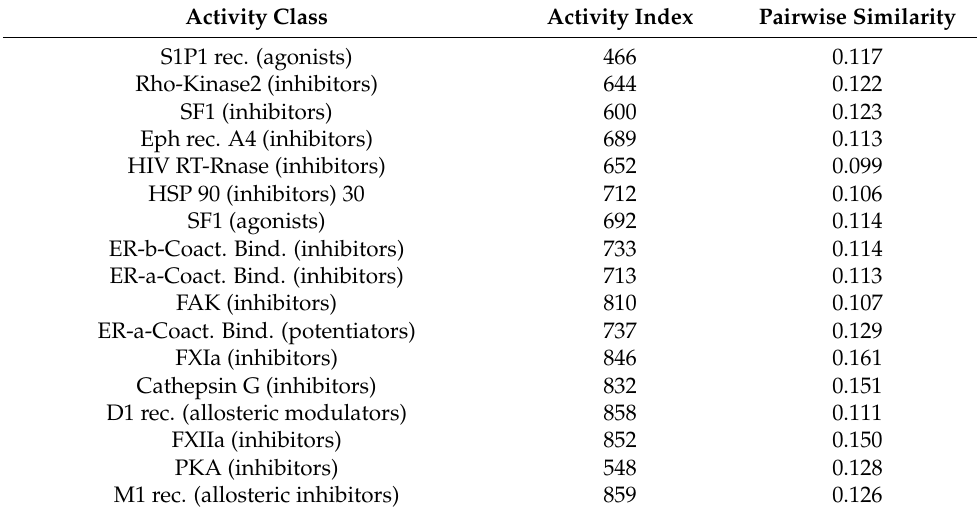
Table 4. MUV structure activity